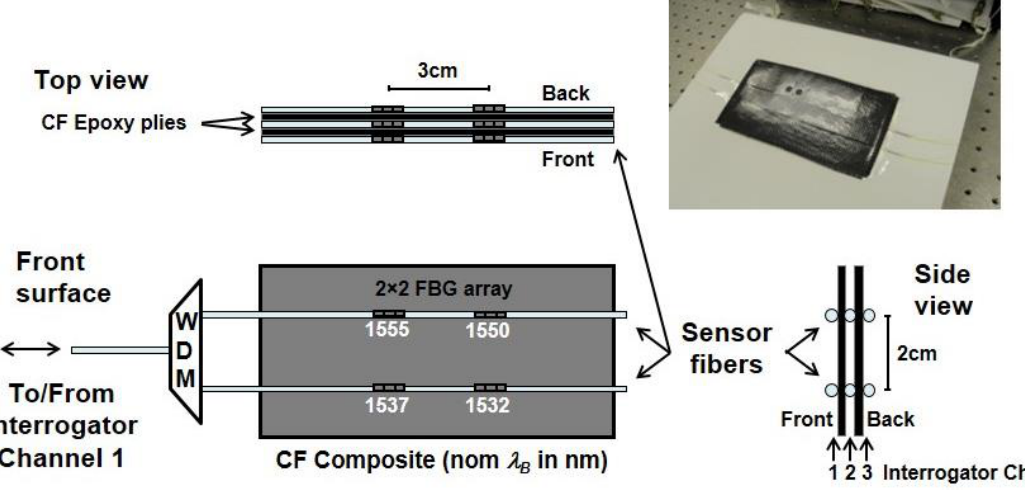
Figure 9. Test setup used to measure the response of a 2 × 2 × 3 array of sensors embedded on the surface and between two plies of CF composite. The nominal Bragg wavelengths of the FBGs are as shown. The actual composite specimen is shown in the upper right.